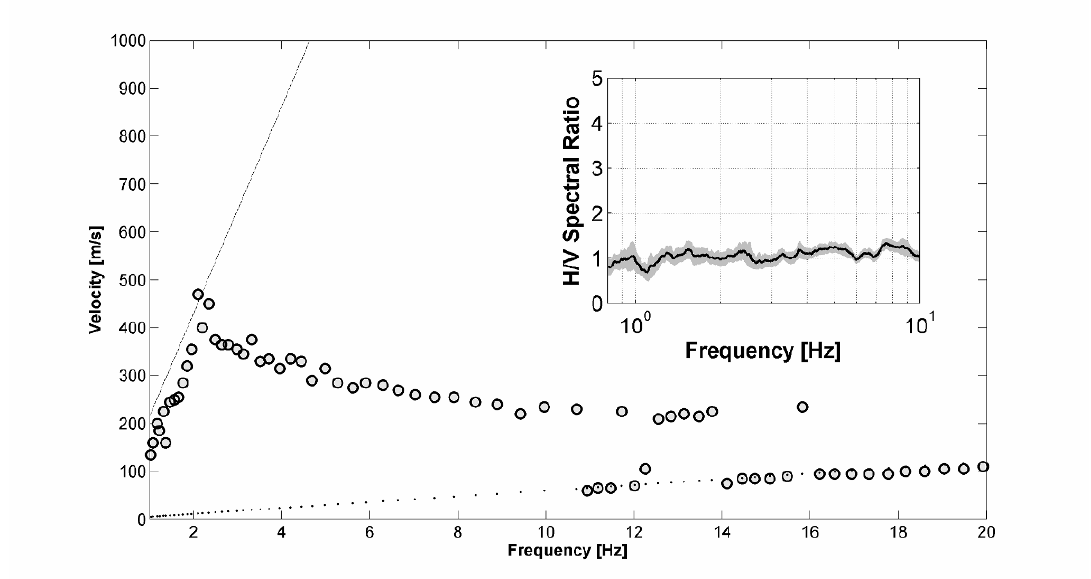
Figure 8. Results of the surface-wave analysis. Main panel : Rayleigh-wave dispersion curves. Experimental phase velocities ( gray dots ), theoretical limit for the spatial aliasing ( dotted line ), and theoretical limit for the spatial resolution ( black line ). Inset: horizontal- to-vertical spectral ratio curve. Average H/V values ( black line ), and the 95% confidence interval ( gray area